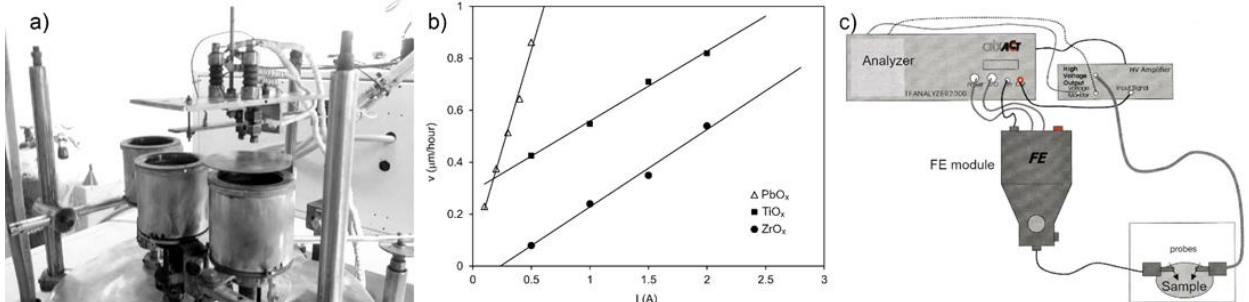
Figure 1. ( a ) Experimental equipment; ( b ) deposition velocity dependence on the magnetron cathode current at the same conditions; ( c ) dielectric properties measurement setup (adapted with permission from Ref. [31]. Copyright 2000, aixACCT Systems GmbH).